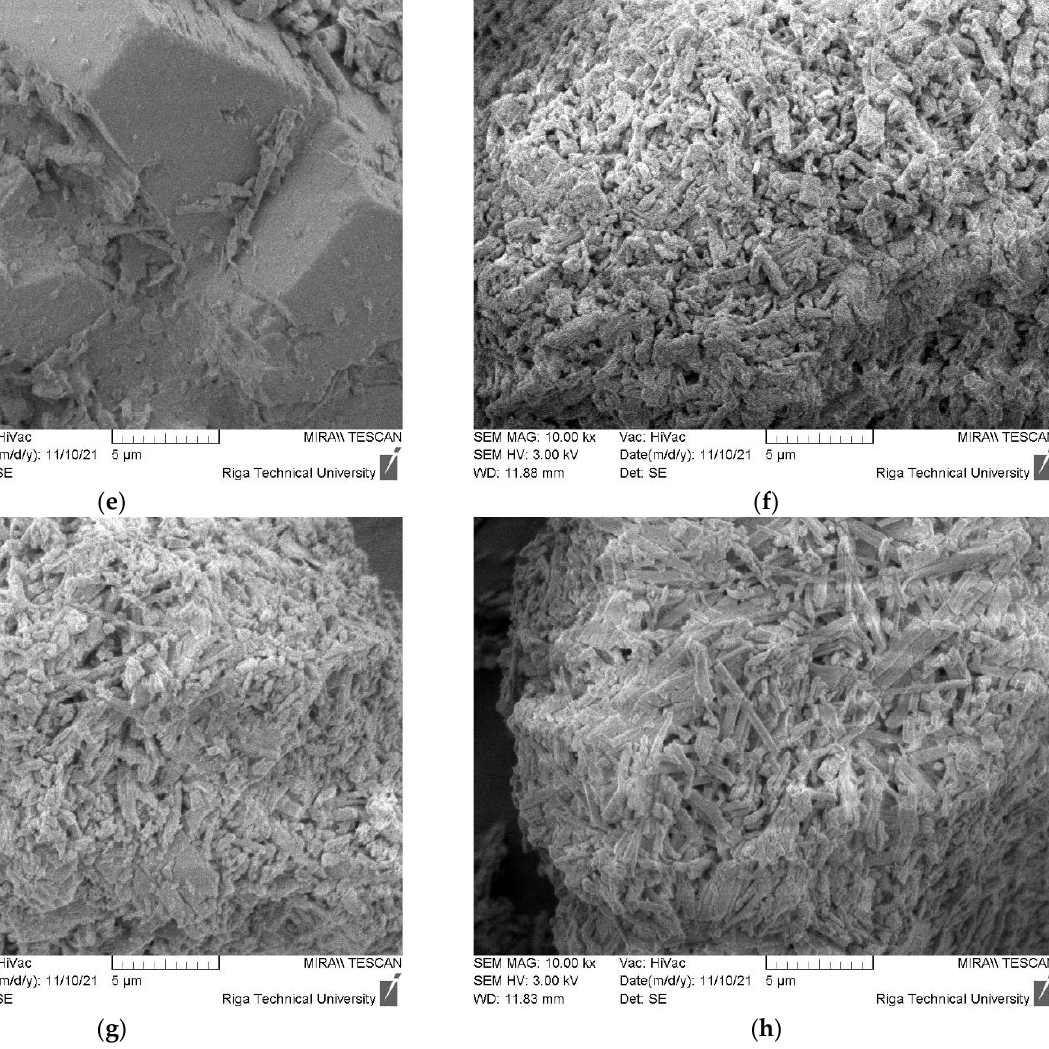
Figure 6. Morphology of CDW gypsum. ( a – d ) Untreated CDW gypsum; ( e – h ) heat treated at 180 °C for 4 h. ( a , e ) MG, ( b , f ) Type F, ( c , g ) Type H, ( d , h ) Type A.